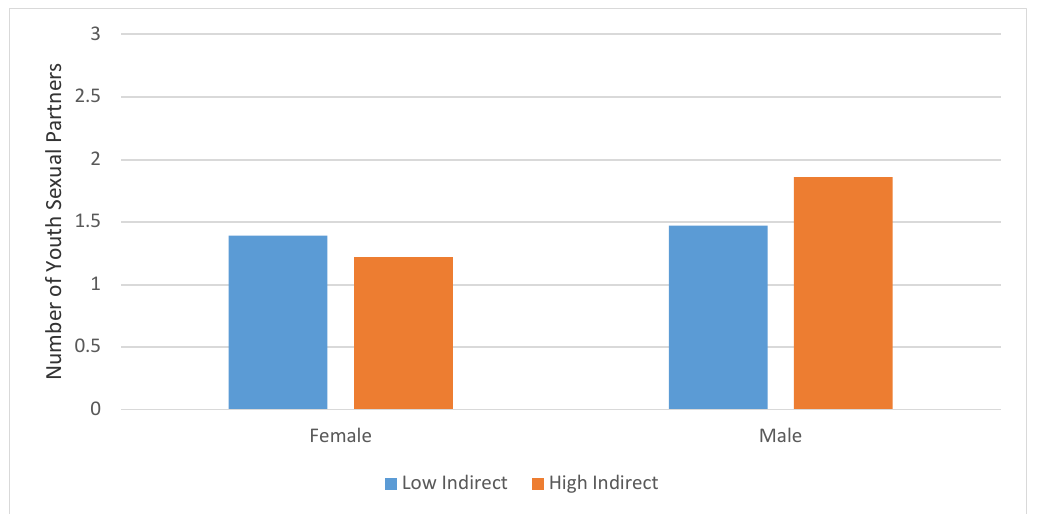
Figure 1. Teen gender as a moderator of the link between father–teen indirect communication and number of sexual part- ners.